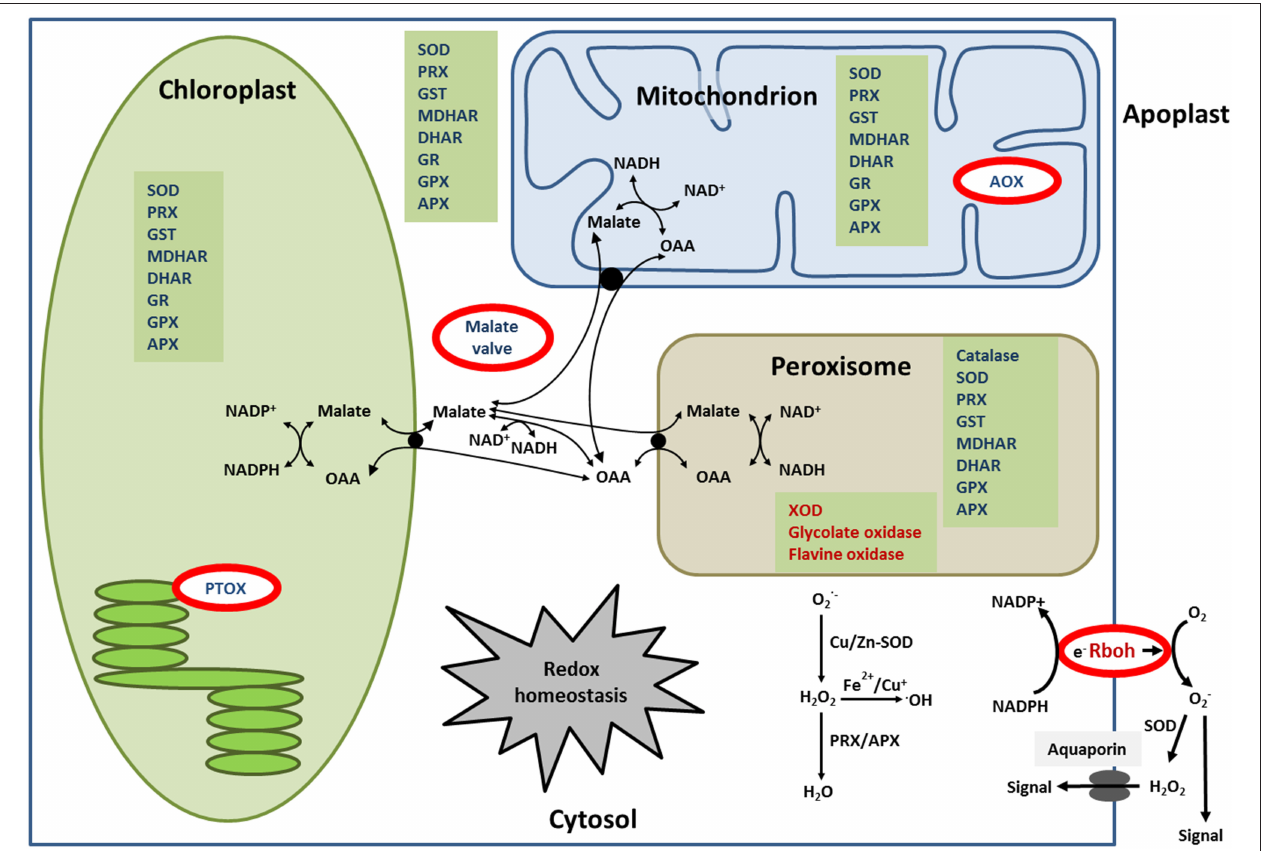
FIGURE 3 | Overview of the antioxidant systems and the malate valve. This figure shows the distribution of the various antioxidant defense systems and the function of the malate valve as mechanism to equilibrate reductive power between organelles.